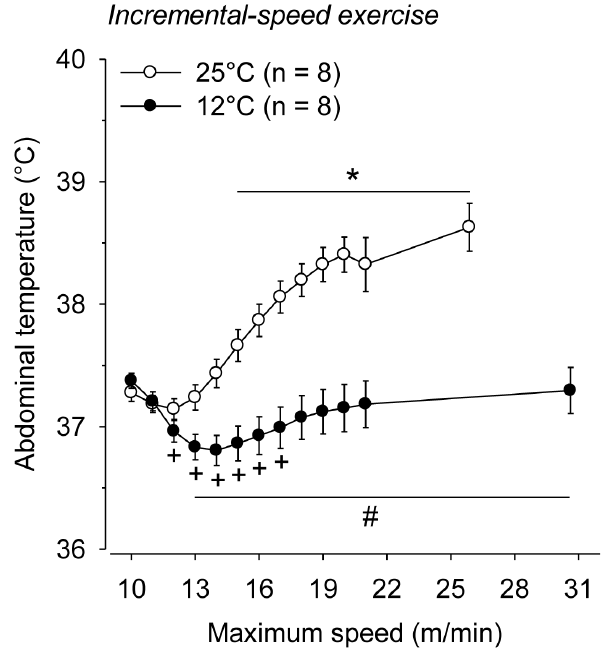
Figure 1. Abdominal temperature during incremental-speed exercises that were performed until volitional fatigue at ambient temperatures of 25 u C and 12 u C. * P , 0.05 compared with the beginning of the exercise at 25 u C; + P , 0.05 compared with the beginning of the exercise at 12 u C; # P , 0.05 compared with the experimental trial at 25 u